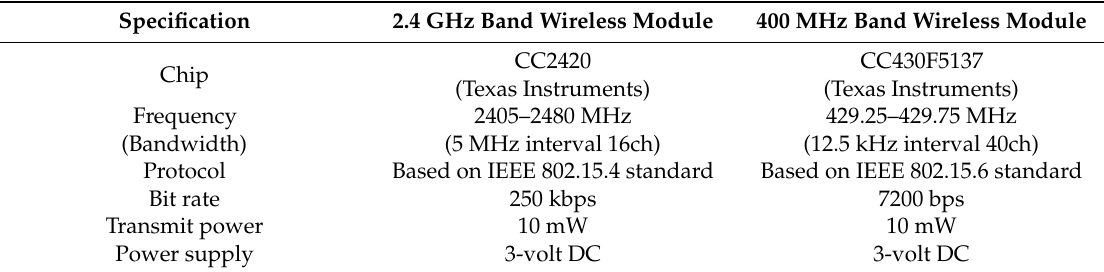
Table 1. Specifications of the wireless